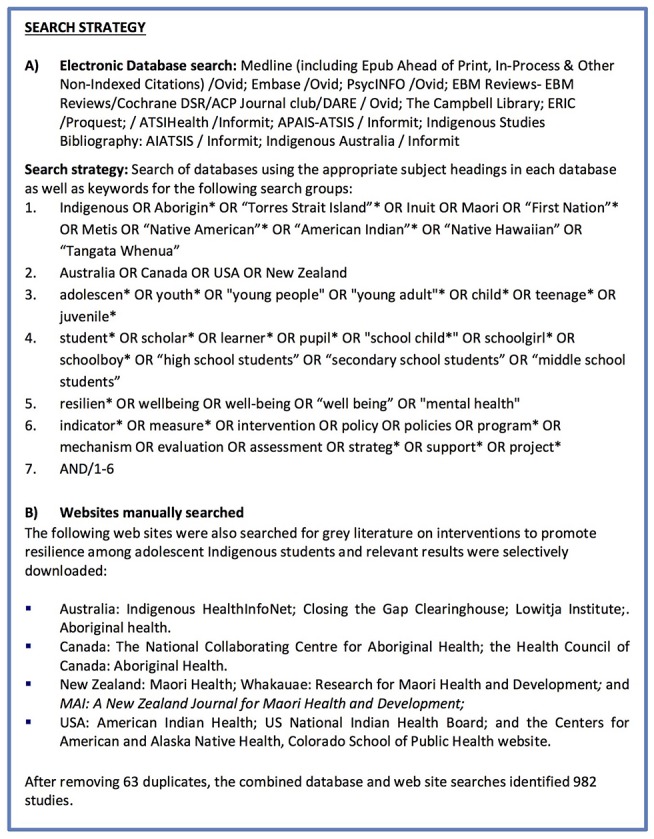
Search strategy.